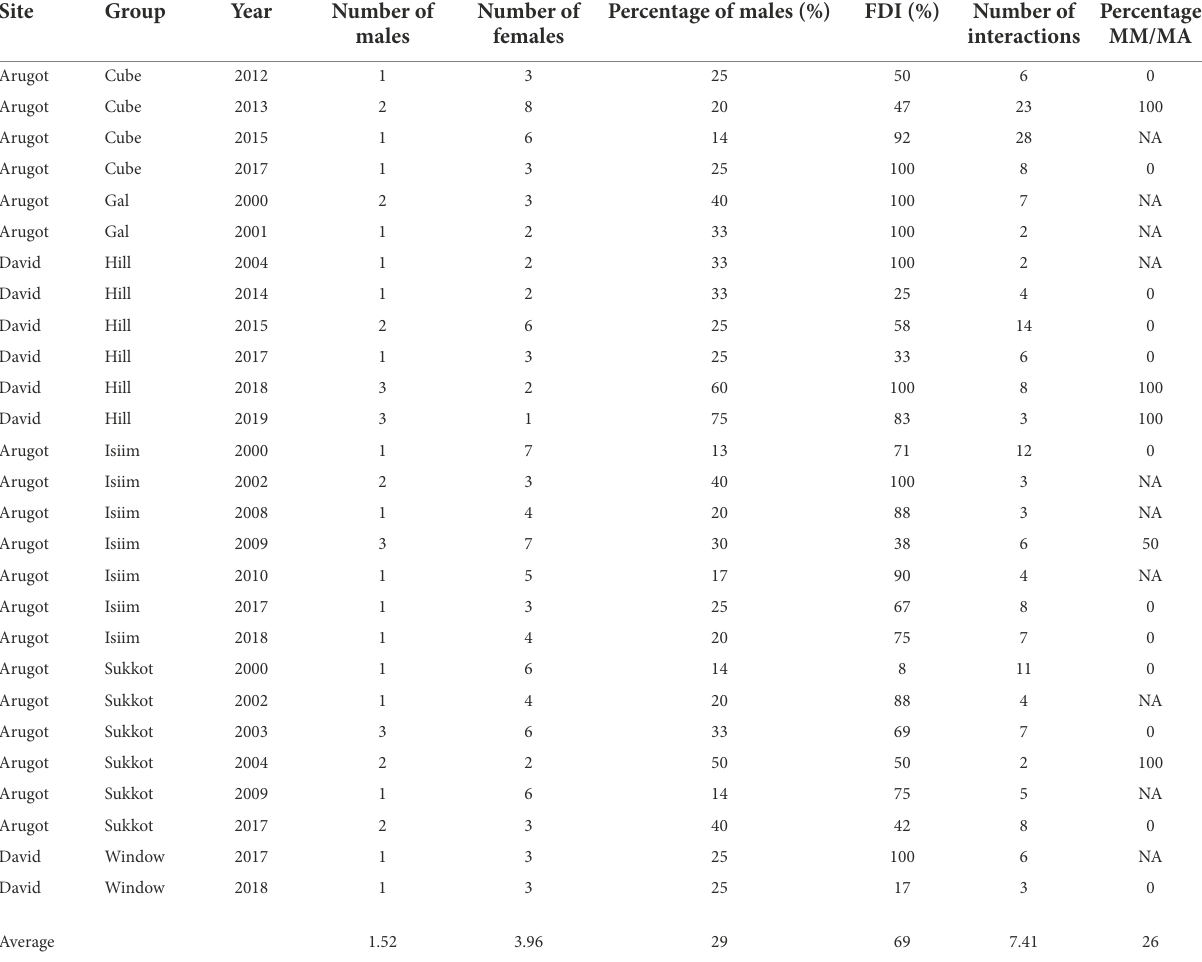
TABLE 1 Summary results of agonistic interactions among adults in rock hyrax groups in Ein Gedi,